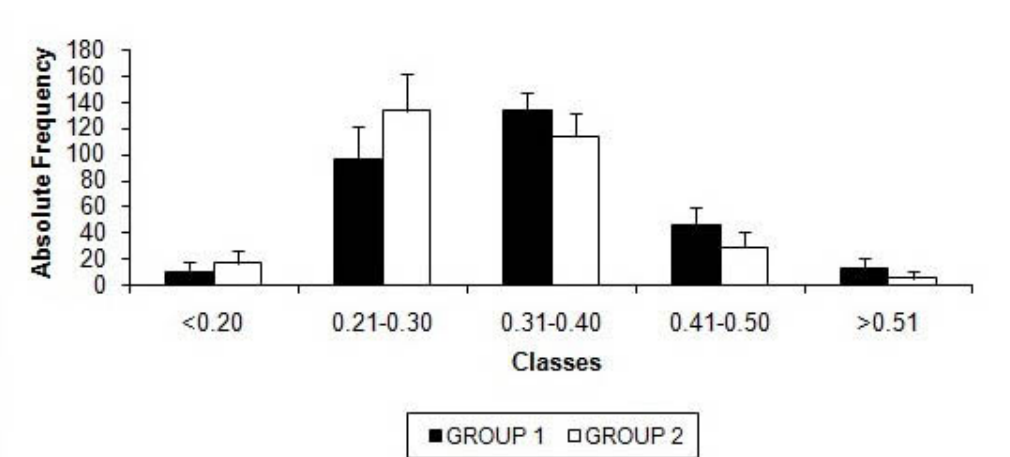
Figure 3. Histogram of the nuclear/body cell area ratio of jejunum myenteric neurons from healthy rats (G1) and those infected with a genotype III Toxoplasma gondii strain